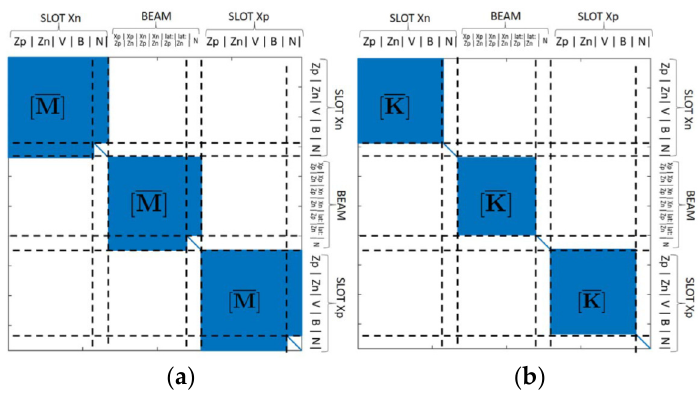
Figure 15. Assembly of super-element: ( a ) mass matrices and ( b ) stiffness matrices.